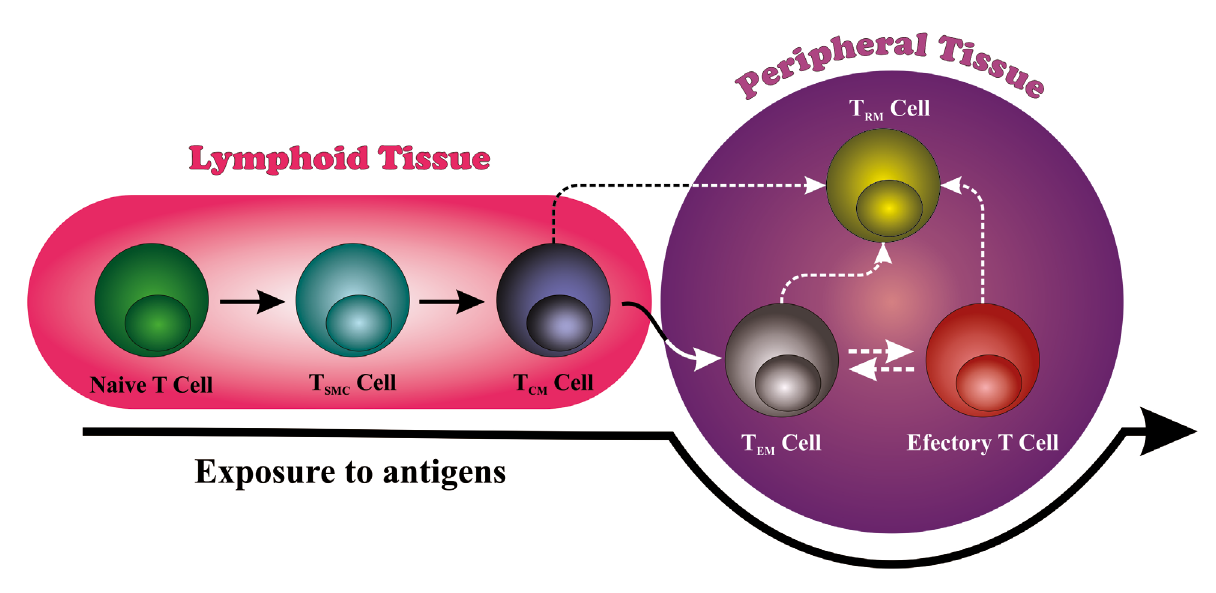
Figure 2. T cell subsets generation according to cellular activation and homing. T cells can be differentiated in different populations according to antigen exposure. Moreover, these T cells can be localized in different tissues (lymphoid and peripheral tissues). T T cell. T effector memory T cell. T tissue resident memory T cell. Solid lines represent elucidated mechanism of differentiation. Dashed lines represent EM: RM: mechanisms still